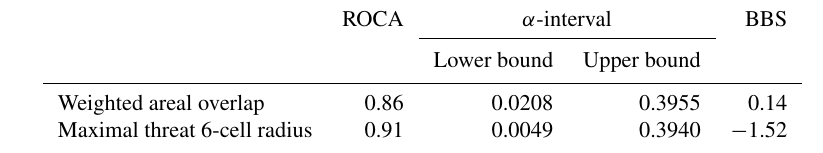
Table 4. BSS and REV characteristics for the two different NWP post-processing methods.